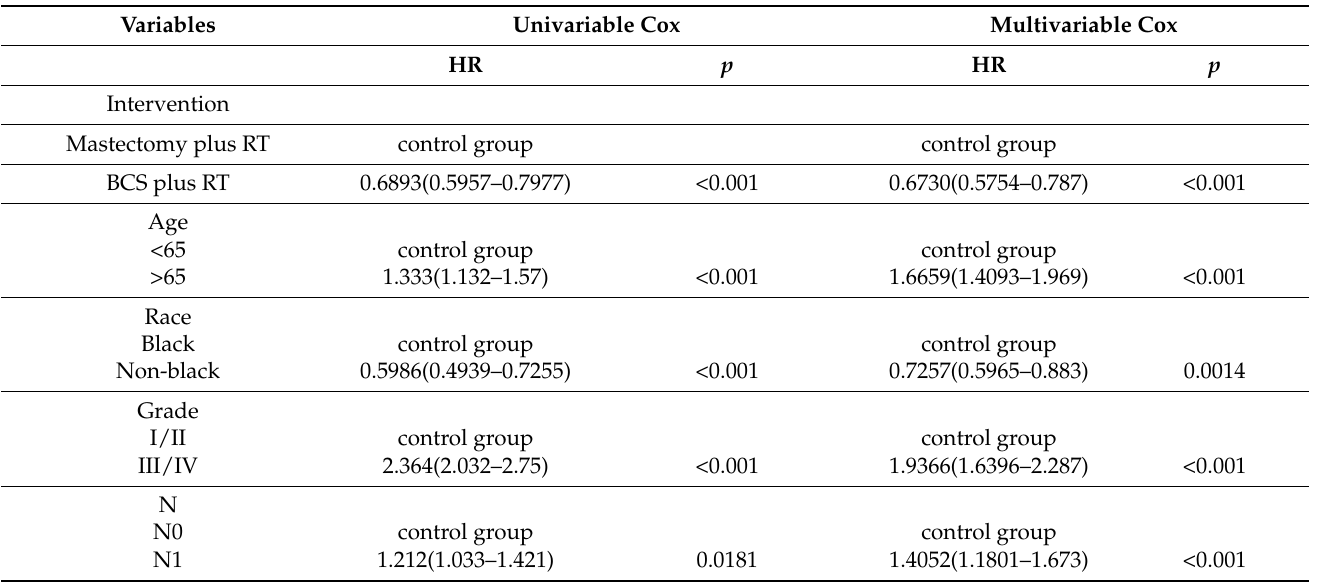
Table 4. Univariate and multivariate analysis of OS for stage II